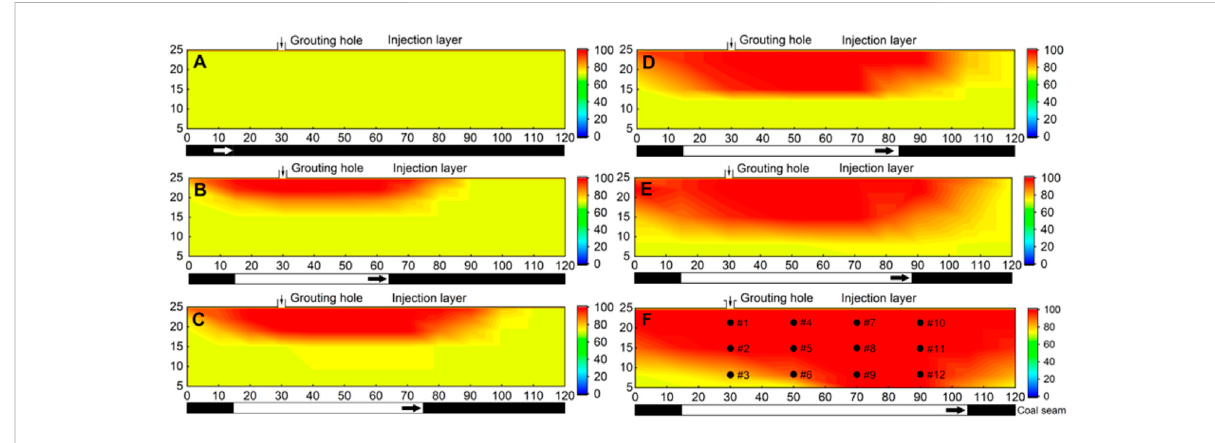
FIGURE 11 Strike pro fi le contour of saturation for α = 0% – 55% along the central location of the inclination during grouting. (A) 0%, (B) 15.6%, (C) 25%, (D) 30%, (E) 38%, and (F) 55%. Here, α is the injection